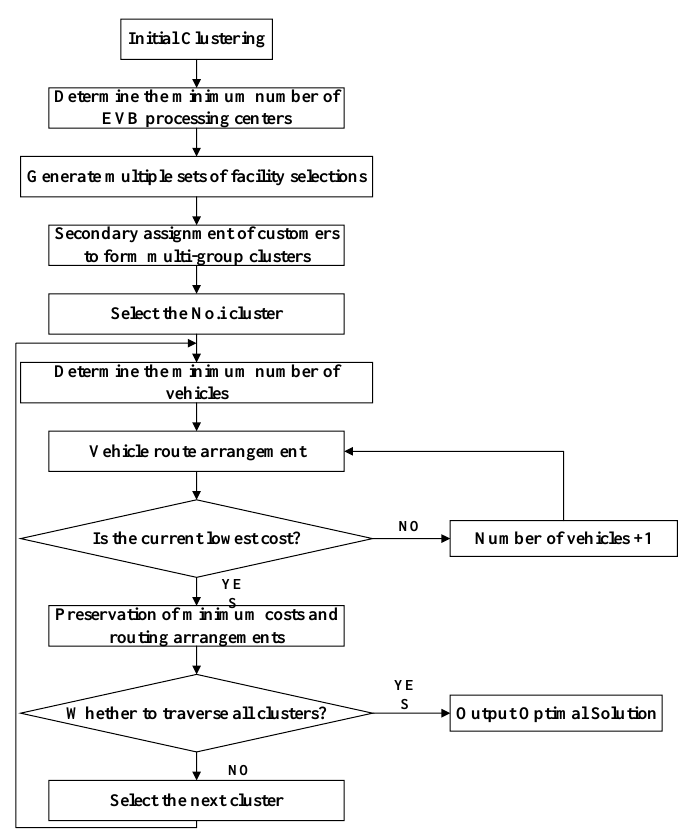
Figure 2. Core steps of the